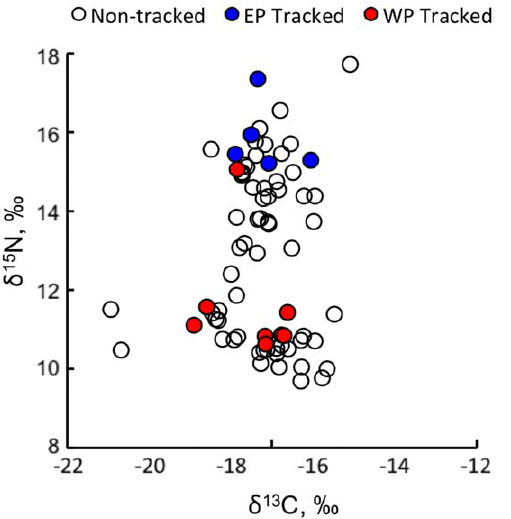
Figure 2. Scatterplot of stable carbon vs. stable nitrogen values for 78 leatherback turtles sampled at the Jamursba- Medi nesting beach in Papua Barat Indonesia.